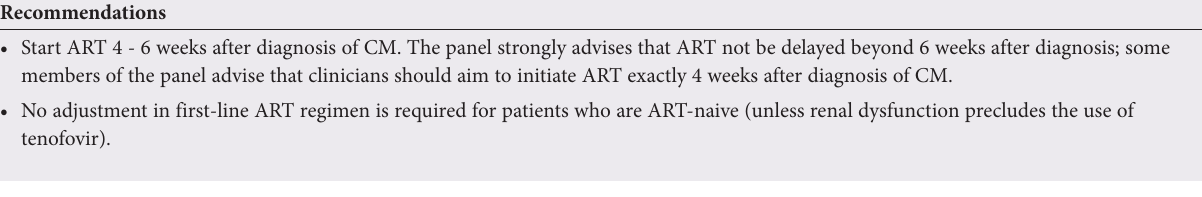
Table 6. Summary of recommendation 6: Management of raised intracranial pressure